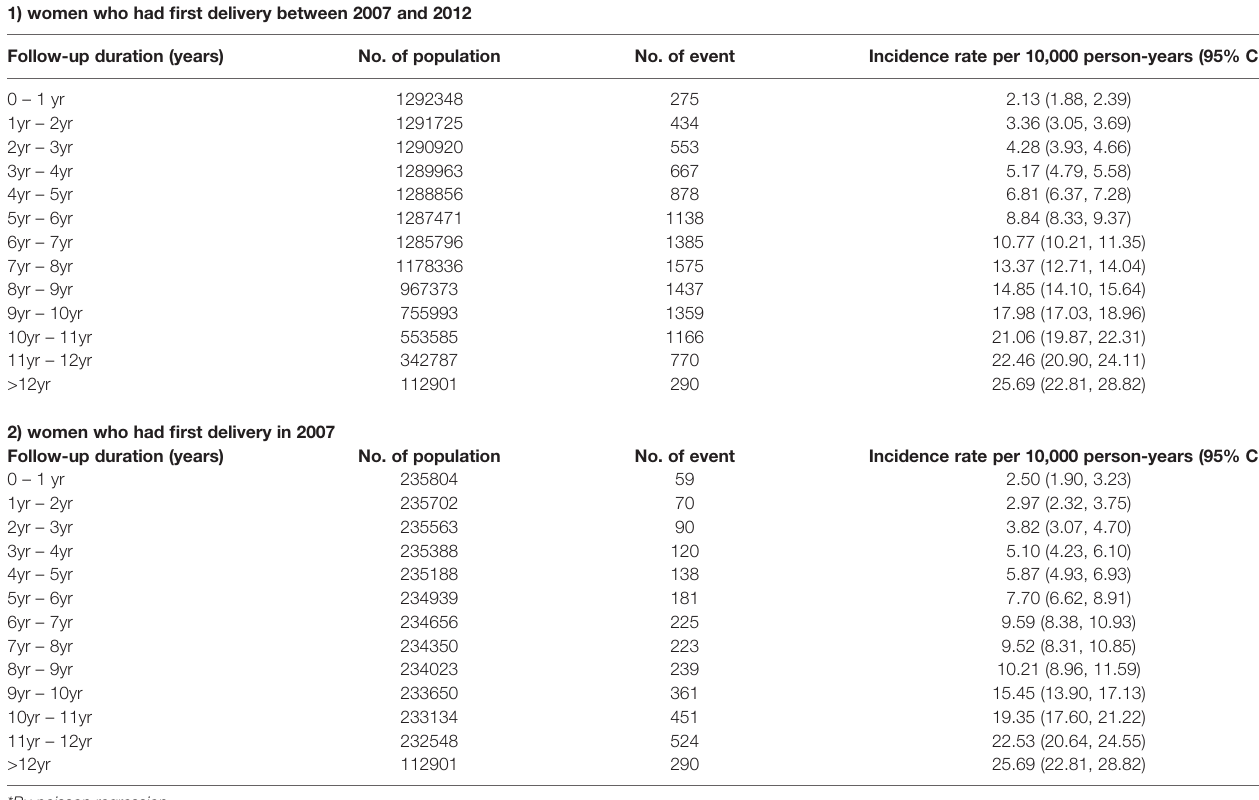
TABLE 1 | Annual incidence rate of women who had fi rst delivery (a) between 2007 and 2012 (b) in 2007 1) women who had fi rst delivery between 2007 and 2012 Follow-up duration (years)